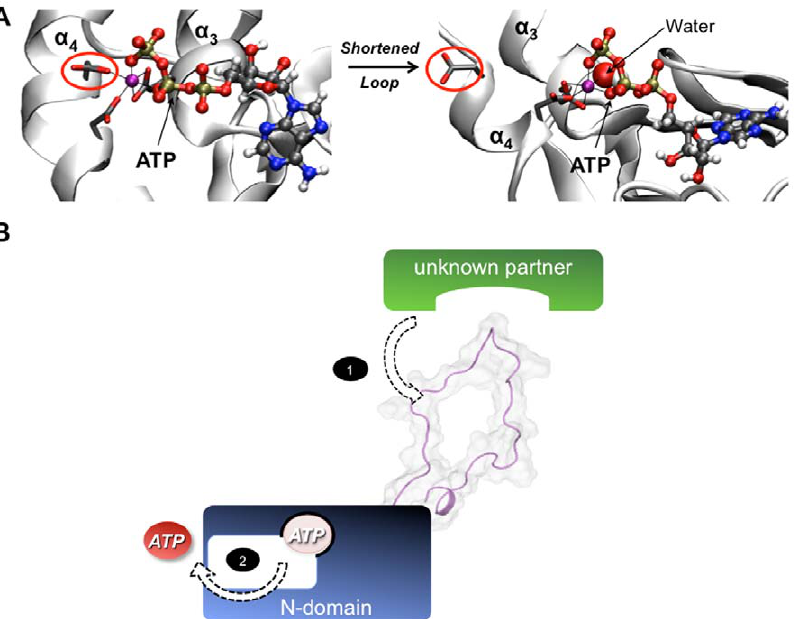
Figure 4. Implication of the flexible loop in ATP binding. (A) Closest trajectory snapshot of the representative structure for the whole and shortened N-domain (cartoon representation) for the WT-Mg-ATP (left) and SL-Mg-ATP (right) systems. The amino acid D1167 is circled in red and side-chains of the ‘‘DDE’’ motif are presented in sticks. ATP and water molecules are shown in ball and stick and VdW, respectively. (B) Schematic proposition of allosteric mechanism promoted by the dynamic loop for the nucleotide release process. The first step of the dynamic response of the loop implies a constraint applied by an unknown partner. The second step is the perturbation of the binding of ATP with the N-domain.